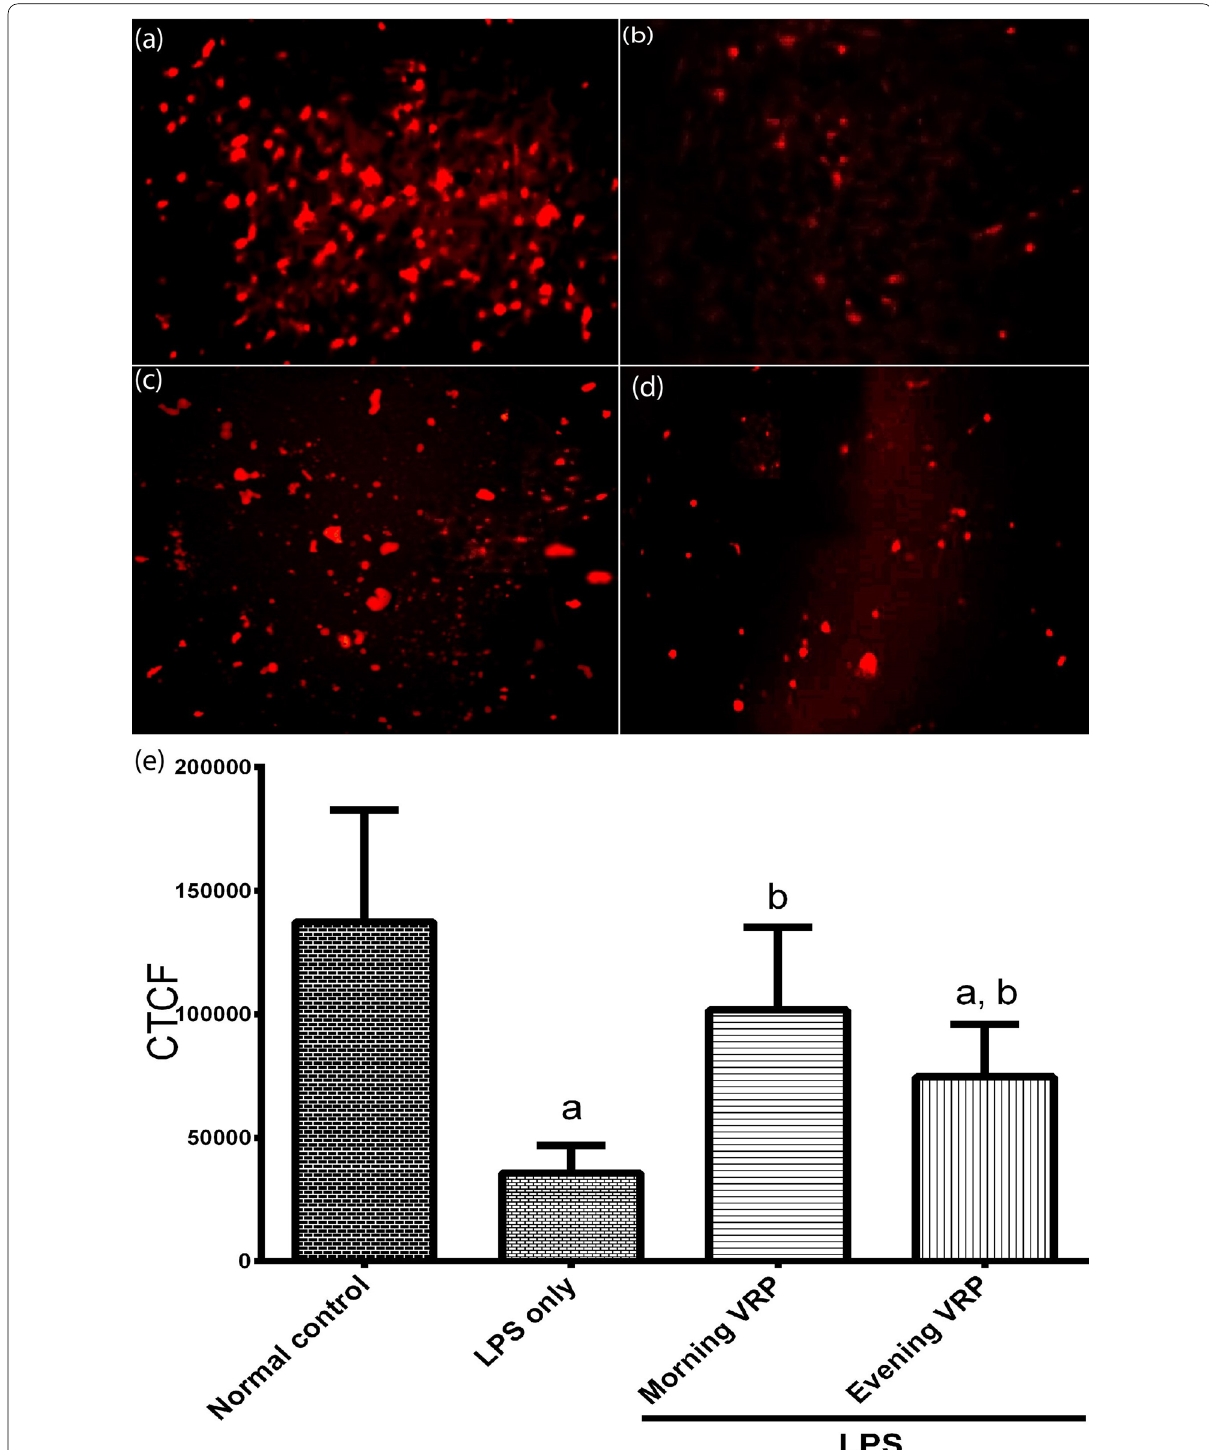
Fig. 6 Effect of VRP on mitochondrial membrane potential. Representative fluorescent images from a Normal control, b LPS only, c Morning VRP, and d Evening VRP. e CTCF, data are expressed as the mean SD and were analyzed using one-way ANOVA followed by Tukey post hoc test. Values ± were considered significantly different at P < 0.05. a: significant versus normal control and b: significant versus LPS only. LPS: lipopolysaccharides, VRP: verapamil, CTCF: corrected total cell